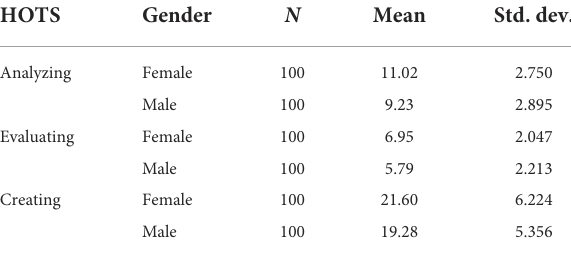
TABLE 4 HOTS levels of the learners.